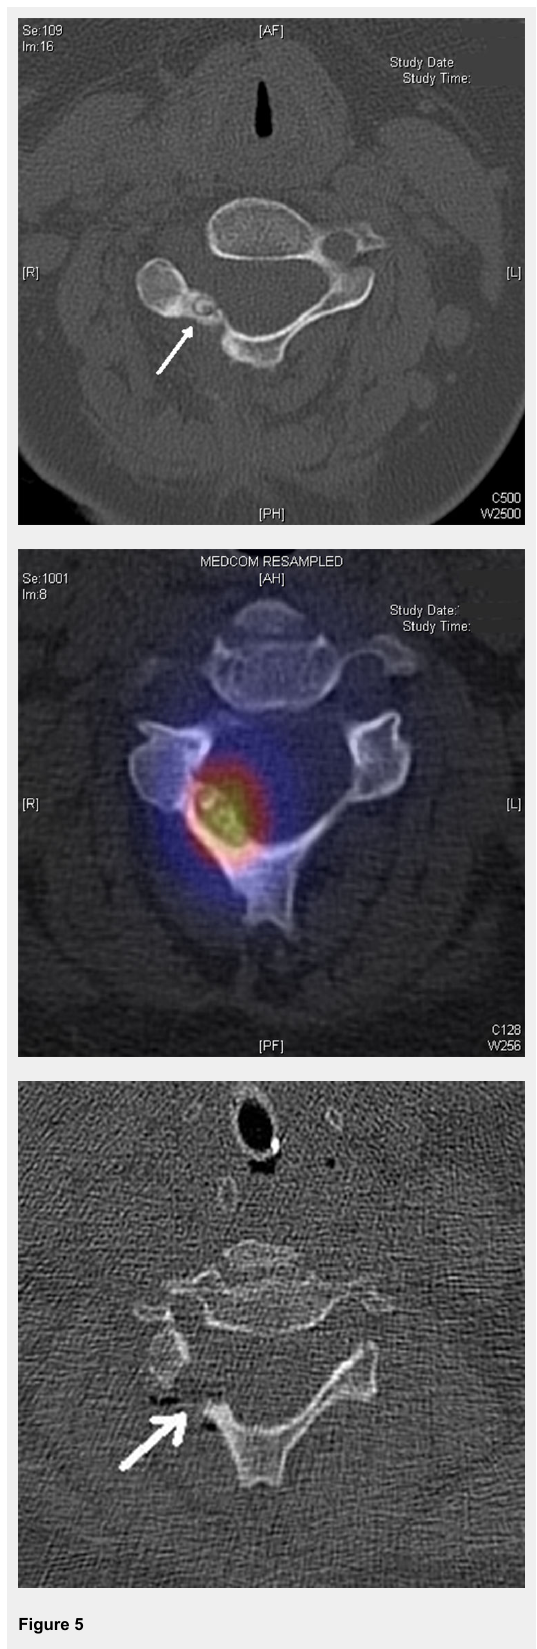
9-year-old boy with a several months long history of right arm and intermittent neck pain ‒ predominantly during the night ‒ which did not respond to physiotherapy. The initial radiograph was found to be normal. A CT scan ( A ) and a SPECT ( B ) revealed an osteoidosteoma in the right lamina of C4. Partial laminectomy led to immediate pain relief ( C